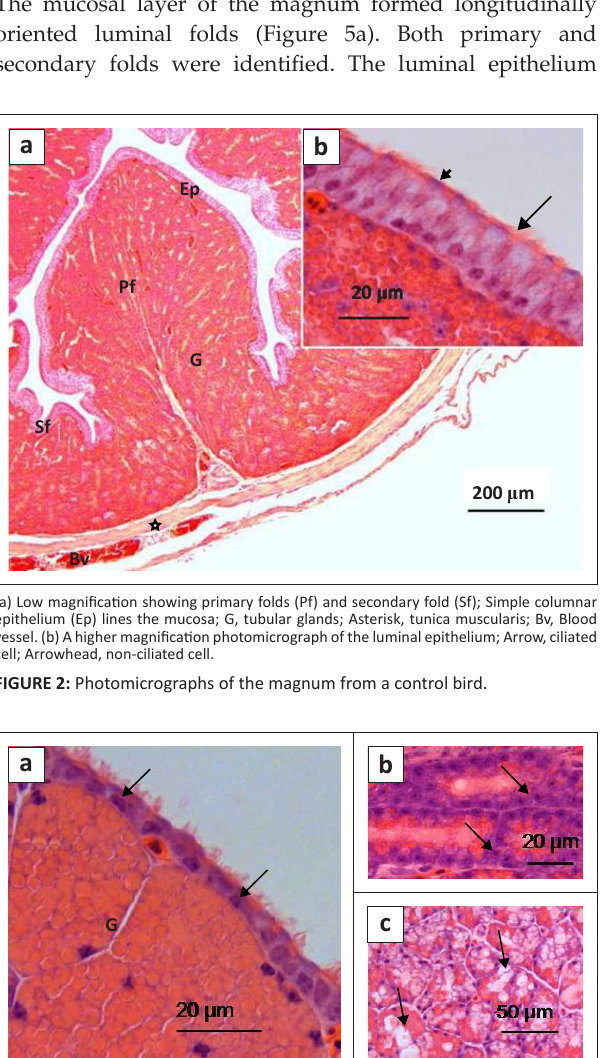
(a) Arrows, pyknotic nuclei; G, tubular glands. (b) Gland cells exhibiting shrunken cytoplasm and pyknotic nuclei (arrows); L, glandular lumen. (c) Gland cells with numerous vacuoles (arrows). FIGURE 3: Photomicrographs of the magnum from a bird treated with carbendazim at a dose of 400 mg/kg